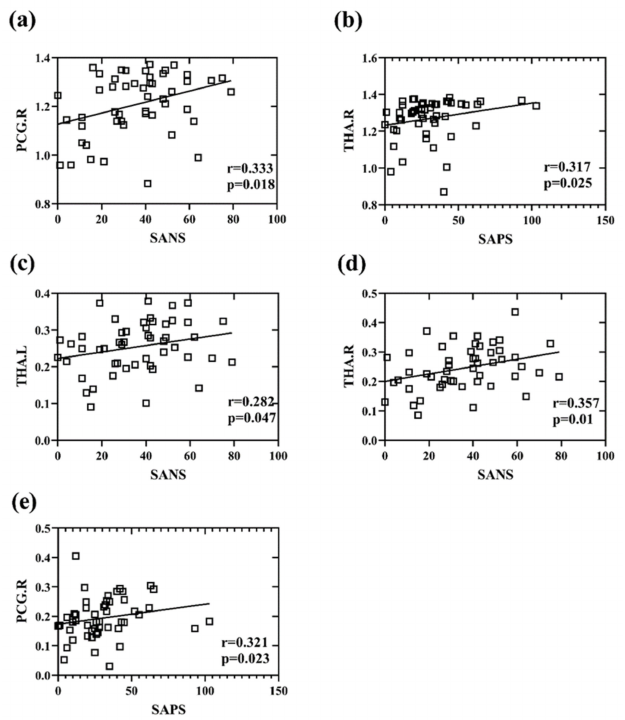
Figure 10. Graph ( a ) shows the correlation between the entropy of the multiplex degree of the right posterior cingulate gyrus (PCG.R) and the SANS. Graph ( b ) depicts the correlation between the